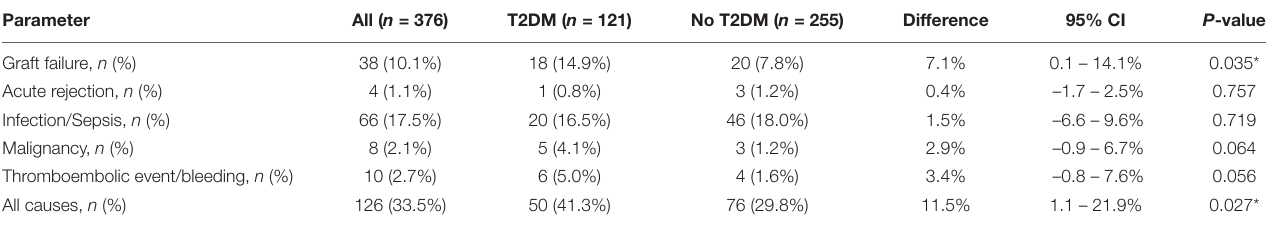
TABLE 6 | Causes of death within 5 years after HTX – stratified by T2DM at